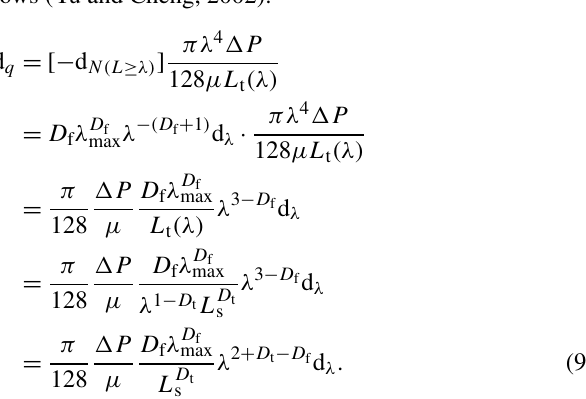
Figure 1. Two different microscale arrangements of solid particles: (a) RTA and (b)